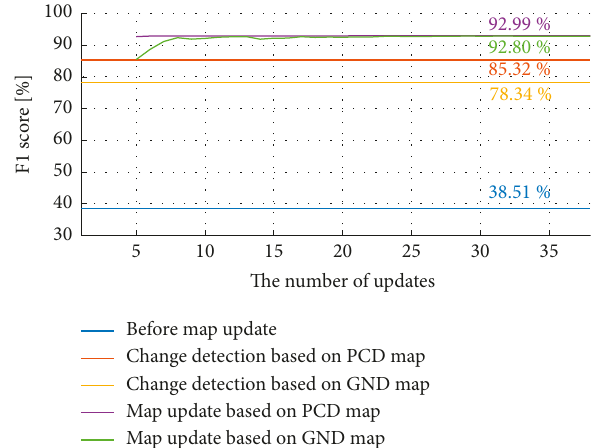
Figure 22: F1-scores by the number of crowd-sourcing vehicles in